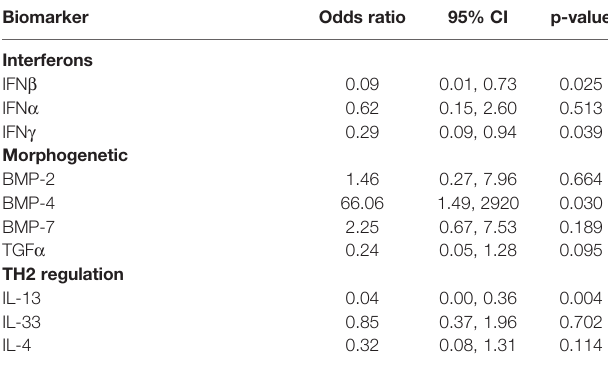
TABLE 2 | Odds ratio (OR) of invasive mechanical ventilation (IMV)/death from fi tting a logistic regression model - log10 scale